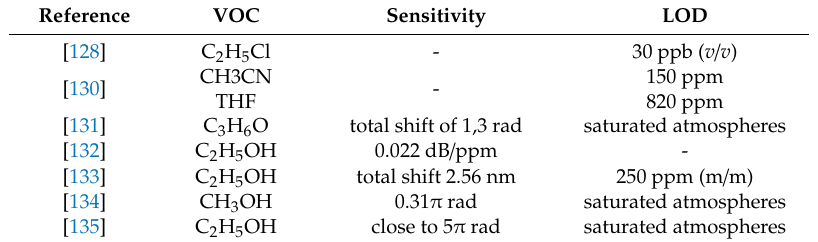
Table 4. Comparative table showing the most relevant features of MOF VOC sensors listed in Section 5.